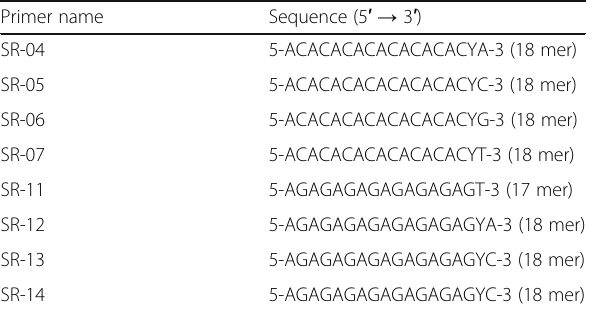
Table 2 Name and sequences of the selected ISSR primers used in ISSR